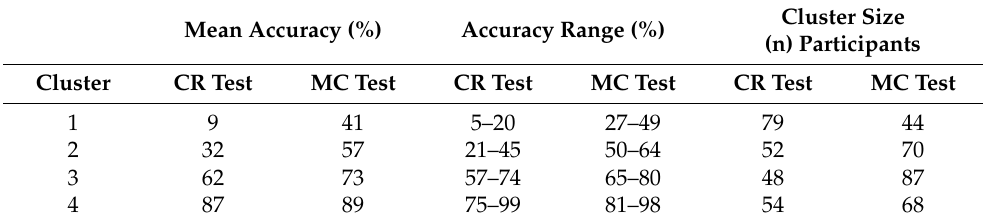
Table 9. Cluster profiles of CR and MC test